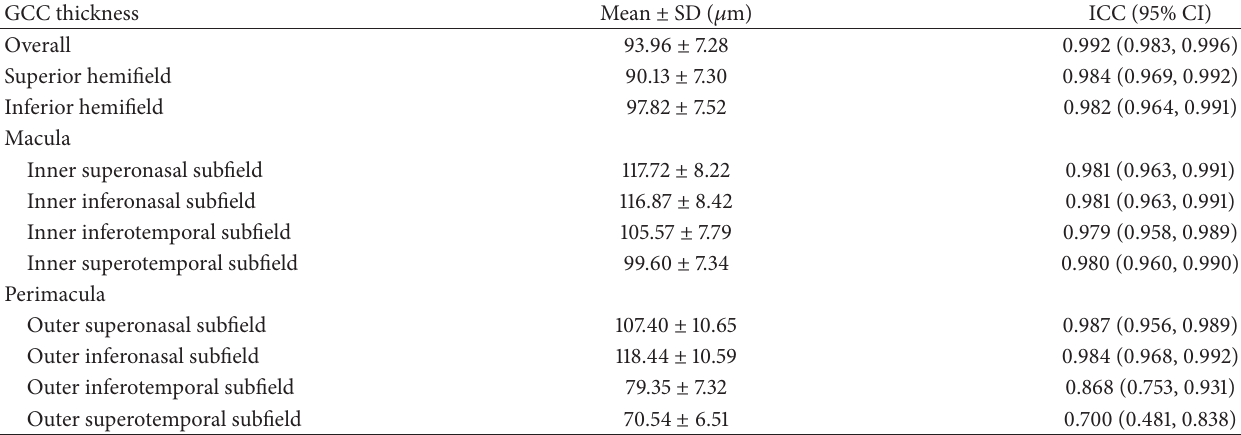
Table 1: Repeatability of ganglion cell complex parameters obtained by OCT-HS100 ( 𝑛 = 34).